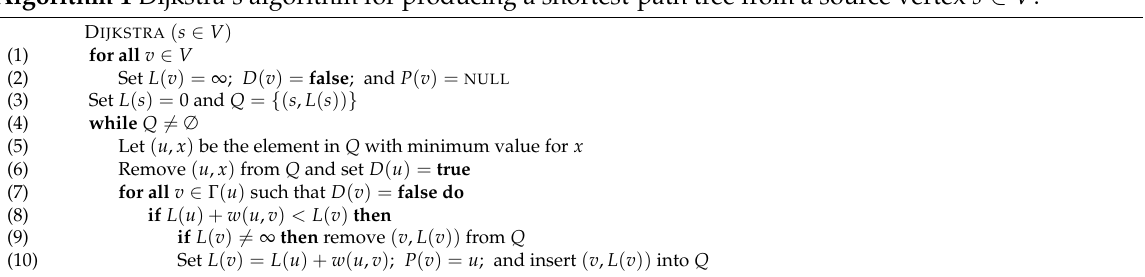
Algorithm 1 Dijkstra’s algorithm for producing a shortest-path tree from a source vertex s ∈ V